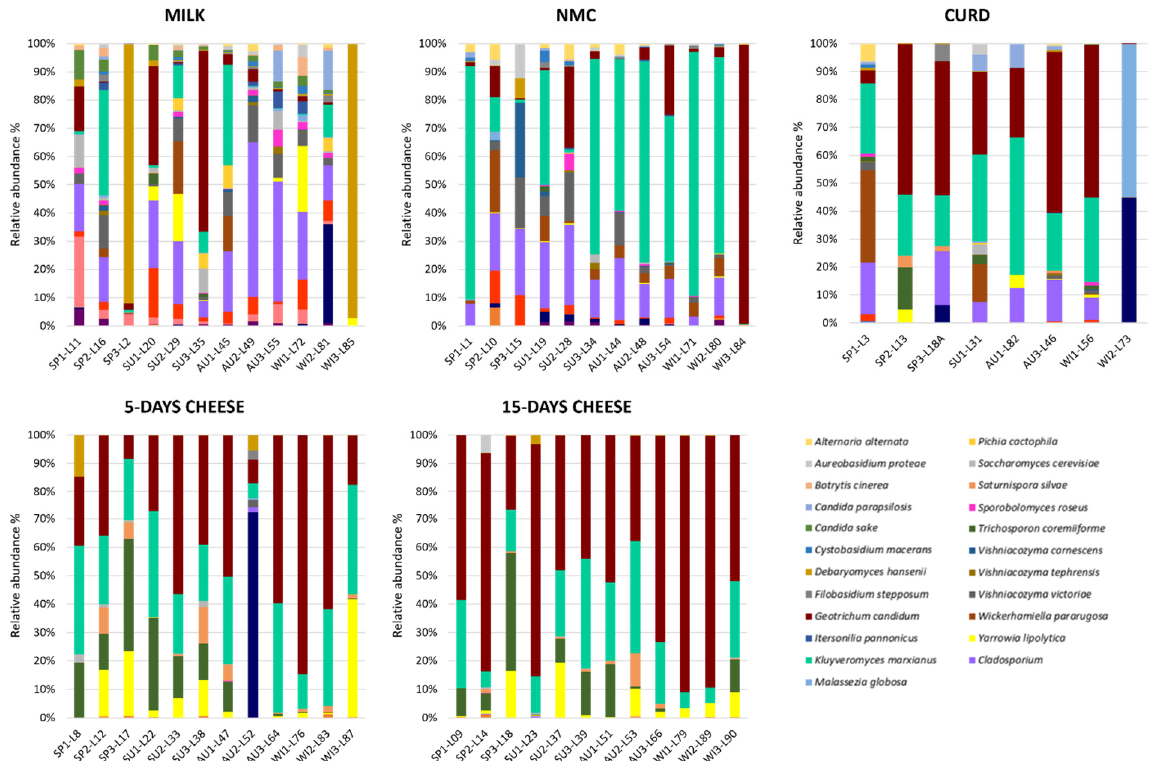
Figure 4. Relative abundance (%) of mycobiota ASVs detected with 26S metataxonomic analysis in milk, natural milk culture (NMC), curd, 5-day and 15-day ripened cheese. Only ASVs with an incidence above 0.5% in at least two samples are shown.